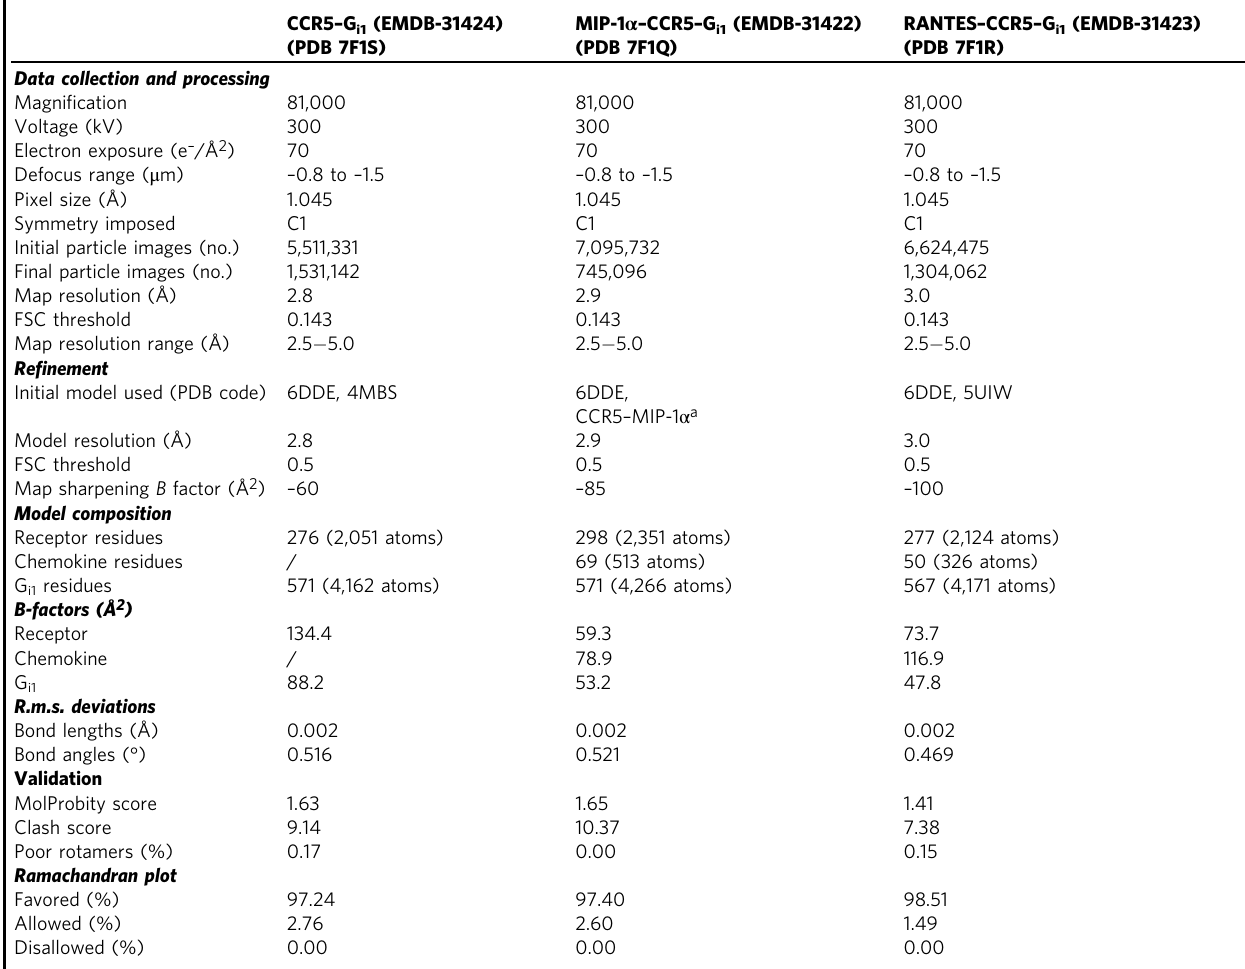
Table 1 Cryo-EM data collection, re fi nement, and validation